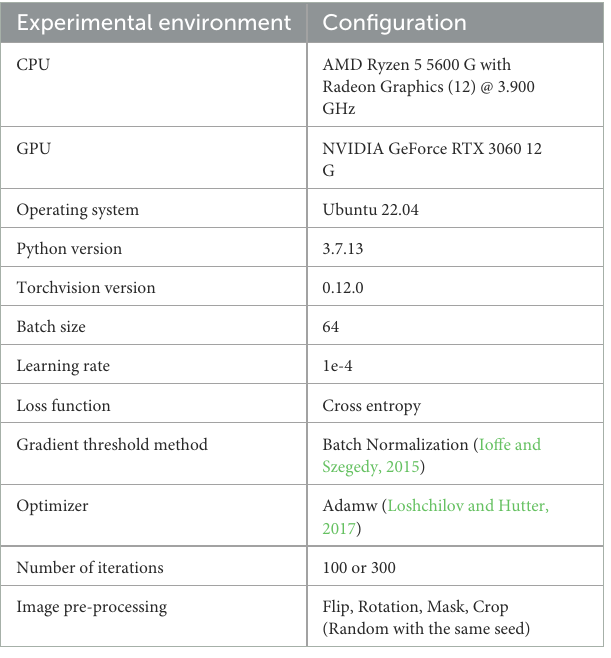
TABLE 1 Experimental environment configuration. Experimental environment